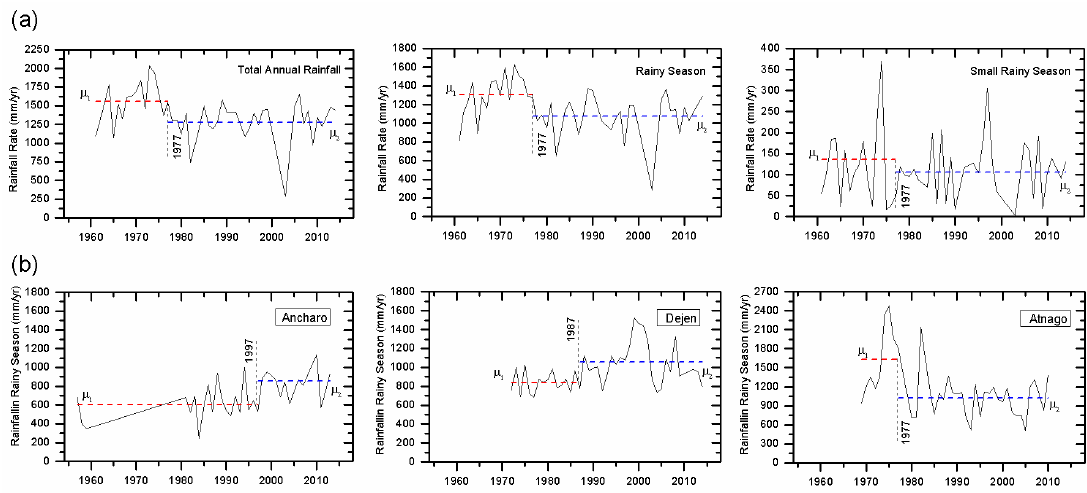
Figure 8. The results for the change points assessment: ( a ) at Bahir Dar station for the total annual rainfall, total rainfall in rainy season, and total rainfall in small rainy season; and ( b ) at Atnago, Dejen, and Ancharo for the total annual rainfall. The dashed lines represent the mean of time series before and after the changing point.